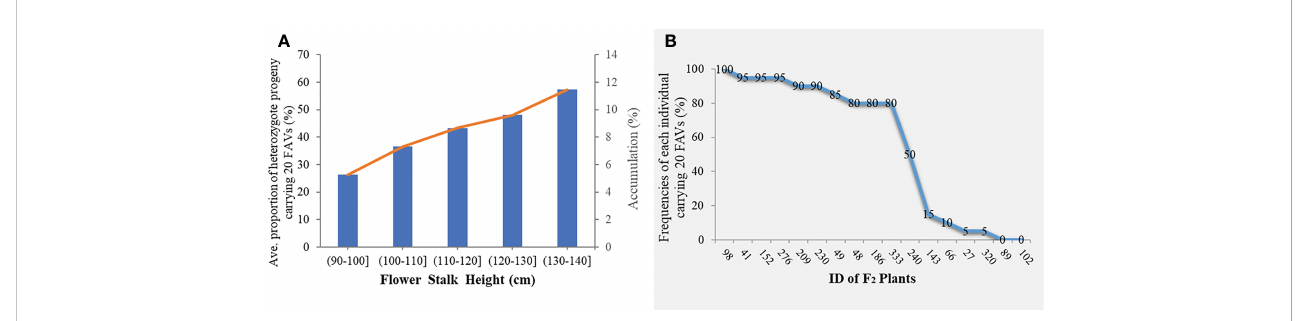
FIGURE 6 Statistical analysis of effective favorable allele varieties (FAVs) in the F 2 population. (A) Average (accumulation) proportion of heterozygote progeny carrying effective FAV markers in the F 2 population. The orange curve indicates the trend curve between cumulative proportion and fl ower stalk height; (B) Frequencies of the 20 FAV loci in the F 2 individuals with the height range from 130-140 cm.